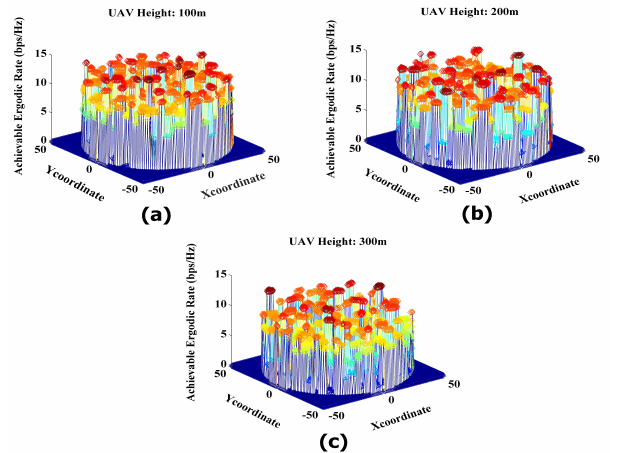
Figure 9. Estimation of achievable ergodic rate of randomly distributed mMTC users within a circular region of a 50 m radius and all UAVs at heights: ( a ) 100 m, ( b ) 200 m, and ( c ) 300 m.